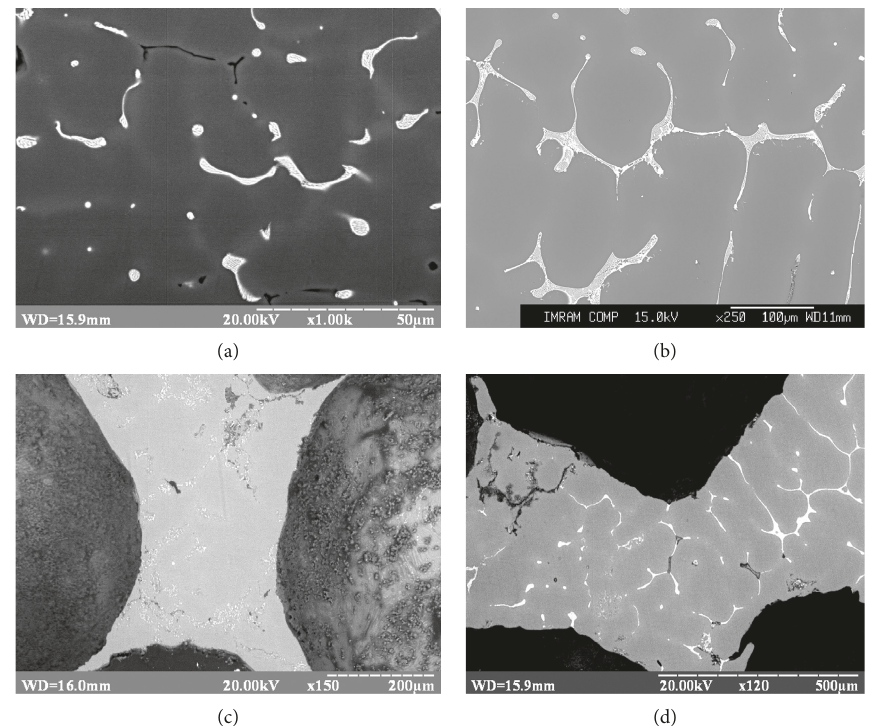
Figure 3: (a, b) SEM micrographs of matrix alloys AlSiMg and AlZnMg, respectively; (c, d) cell wall materials of F1 and F2 foams.